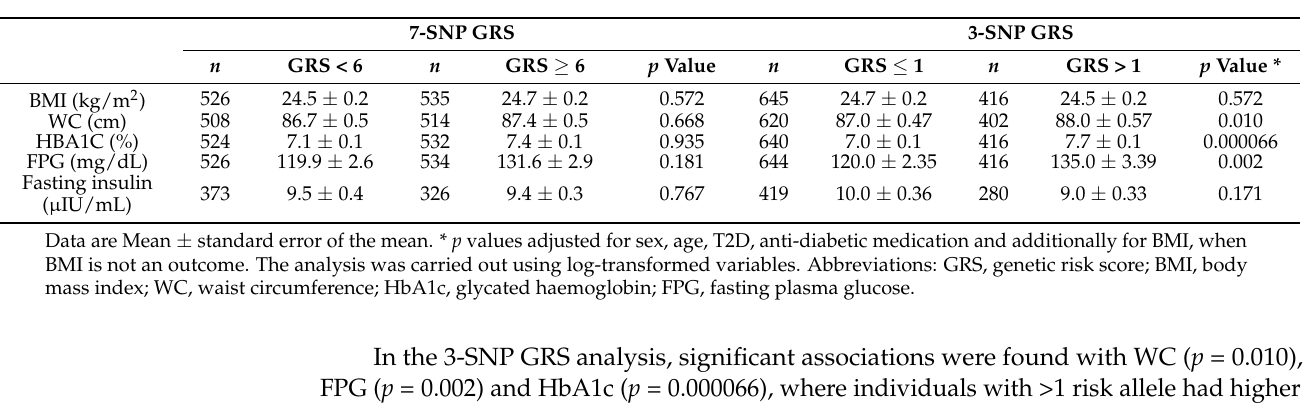
Table 2. Associations of 7-SNP and 3-SNP GRS and with metabolic